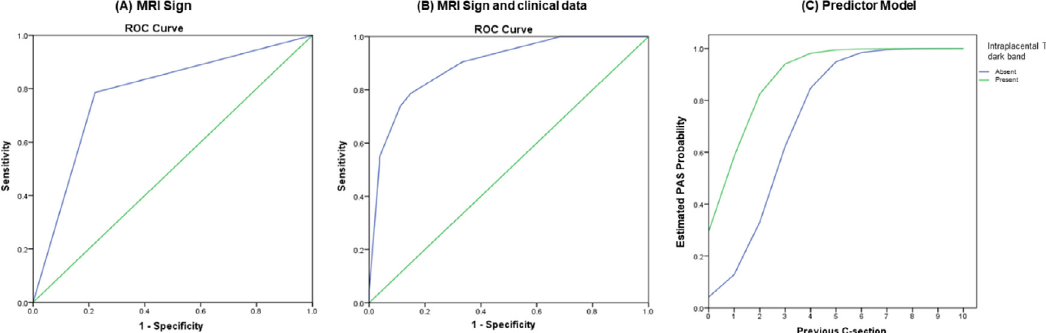
Fig. 6. (A) ROC curve analyses for the prediction of PAS including only MRI sign (intraplacental T2 dark band) with an AUC=0.782 (95 % CI 0.685 ‒ 0.878) and (B) including MRI sign and relevant clinical data (previous C-sections) with an AUC=0.893 (95 % CI 0.829 ‒ 0.957). (C) Predictor model for the estimated PAS probability versus number of previous C-sections of the